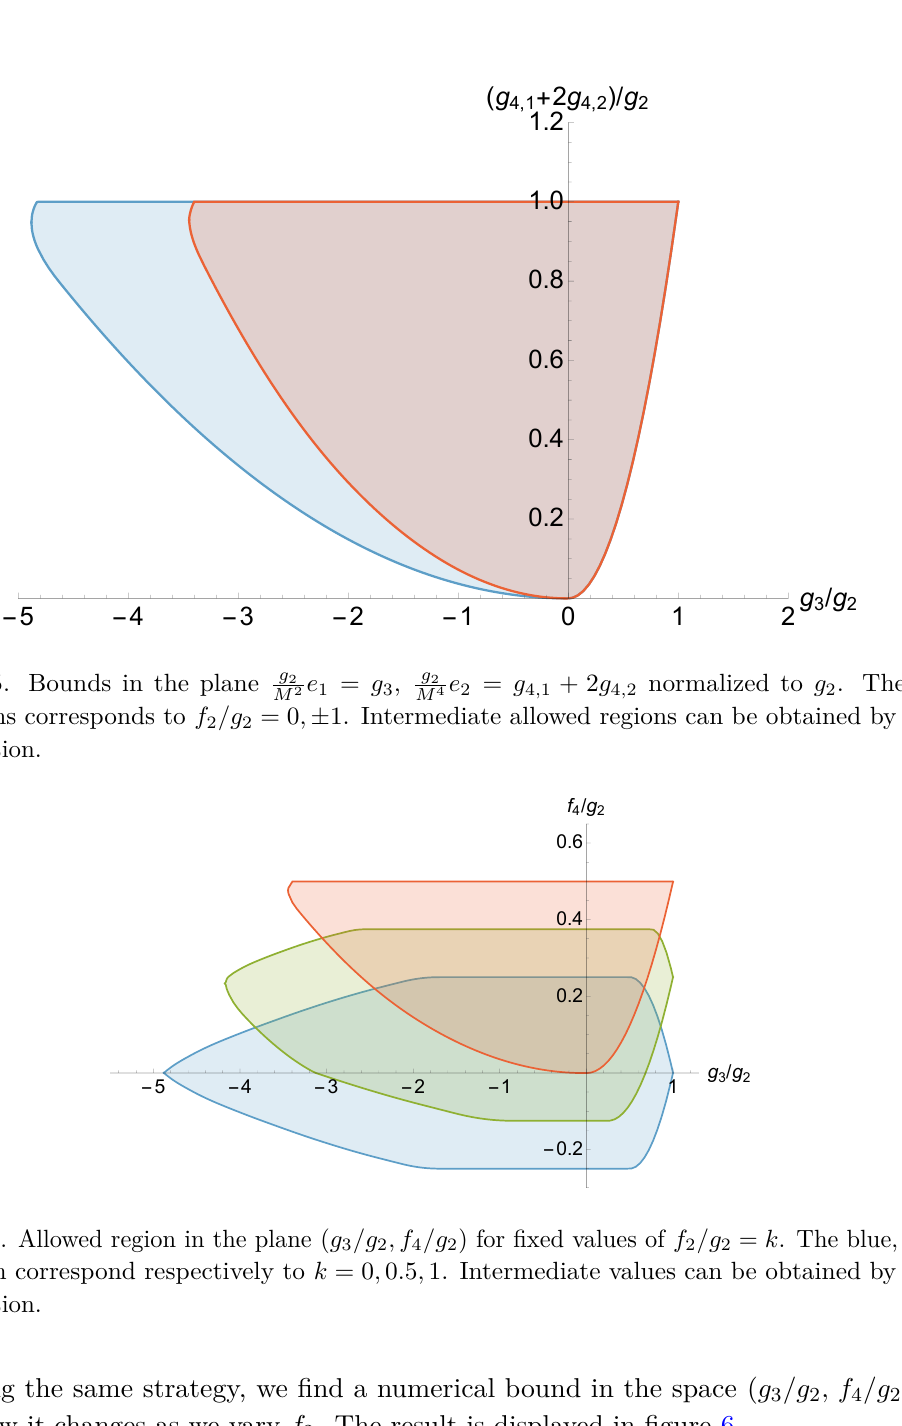
Figure 6 . Allowed region in the plane ( g 3 /g 2 , f 4 /g 2 ) for fixed values of f 2 /g 2 = k . The blue, green, red region correspond respectively to k = 0 , 0 . 5 , 1 . Intermediate values can be obtained by linear